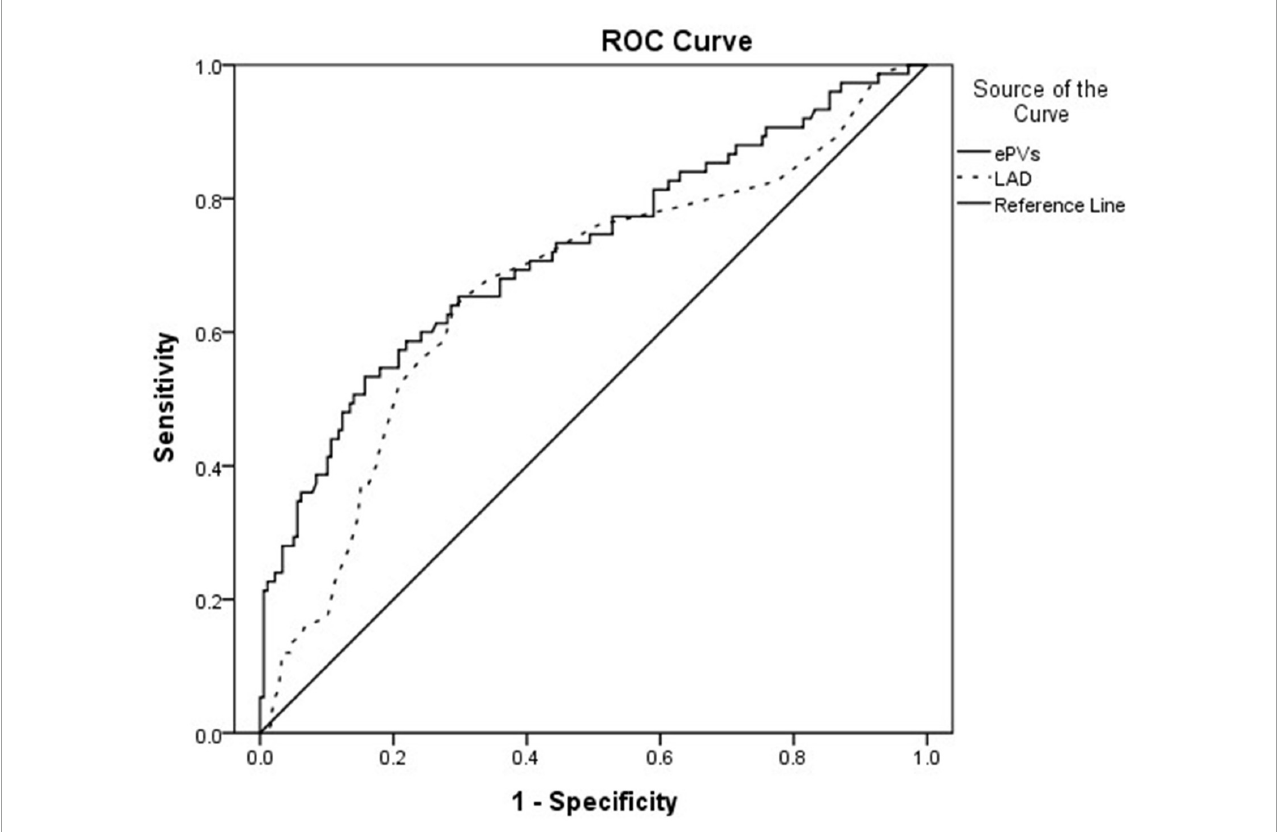
FIGURE1 Receiver operating curve showing the area under the curve (AUC) for estimated plasma volume status (ePVs) and left atrial diameter (LAD).